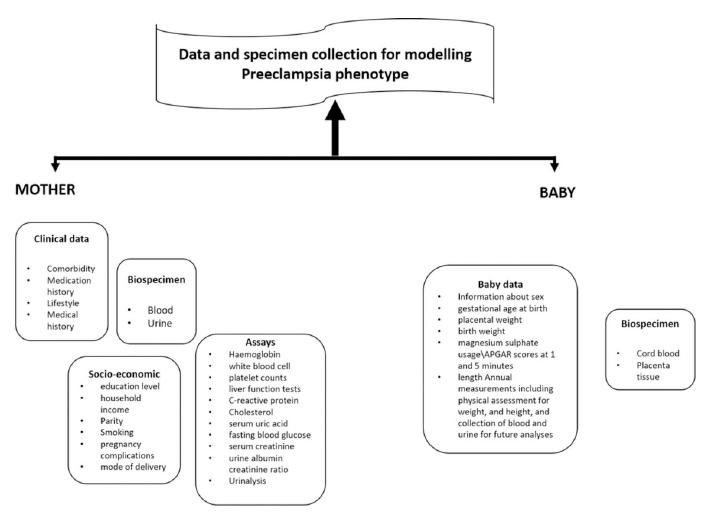
Fig 1. Overview of the clinical